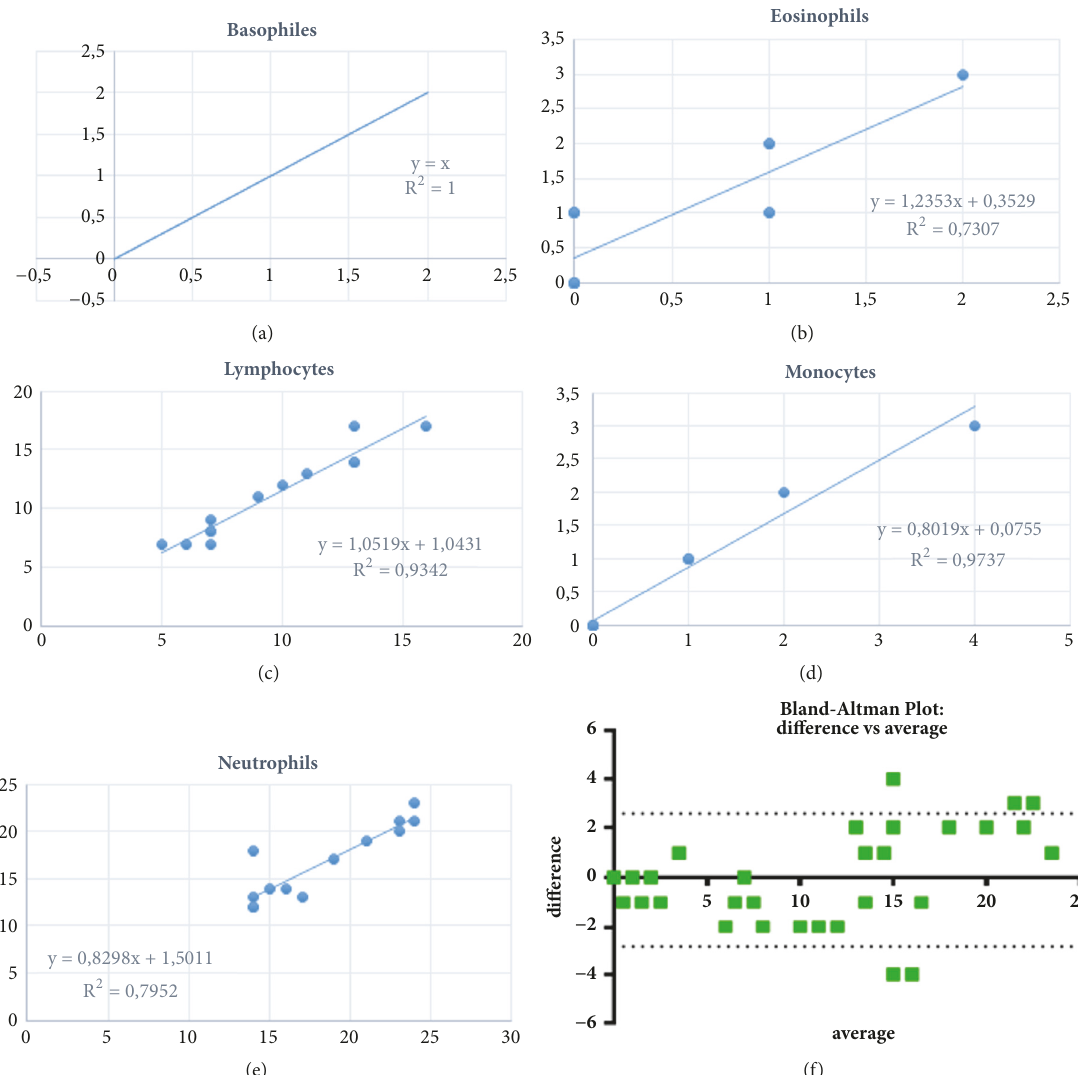
Figure 5: The coefficient of determination for each class of white blood cells. (a) Basophils, (b) eosinophils, (c) lymphocytes, (d) monocytes, (e) neutrophils, and (f) the Bland-Altman test between the professional in hematology and the